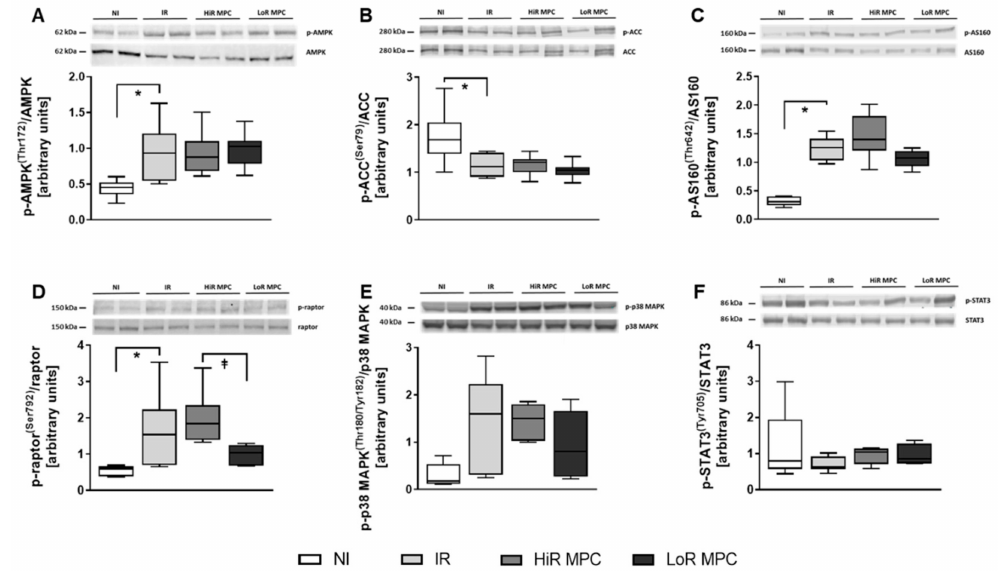
Figure 4. Activation of key signaling molecules—AMPK and Survivor Activating Factor Enhancement (SAFE) pathway. Representative Western blots for phosphorylated and total proteins in top panels and ratios of phosphorylated to total proteins for: ( A ) AMP-activated protein kinase (AMPK) [Thr172]; ( B ) acetyl-CoA carboxylase (ACC) [Ser79]; ( C ) Akt substrate of 160 kDa (AS160) [Thr642]; ( D ) regulatory associated protein of mTOR (raptor) [Ser792]; ( E ) p38 mitogen-activated protein kinase (p38 MAPK) [Thr180 / Tyr182]; ( F ) signal transducer and activator of transcription 3 (STAT3) [Tyr705]. HiR, high recovery; IR, ischemia reperfusion; LoR, low recovery; MPC, mechanical postconditioning; NI, no ischemia. Data are expressed as median, 25–75 percentiles and range. * p < 0.05 vs. IR, ‡ p < 0.05 LoR MPC vs. HiR MPC ( n = 5–10 /